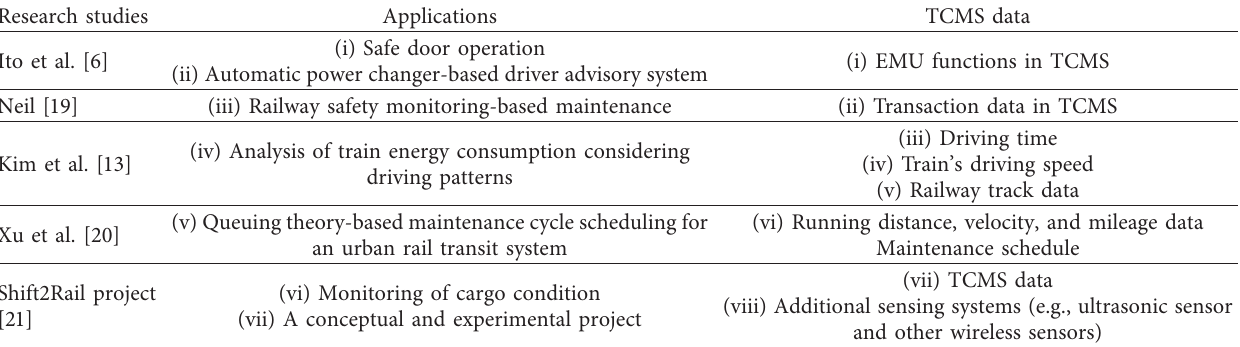
Table 2: Applications that use TCMS data.